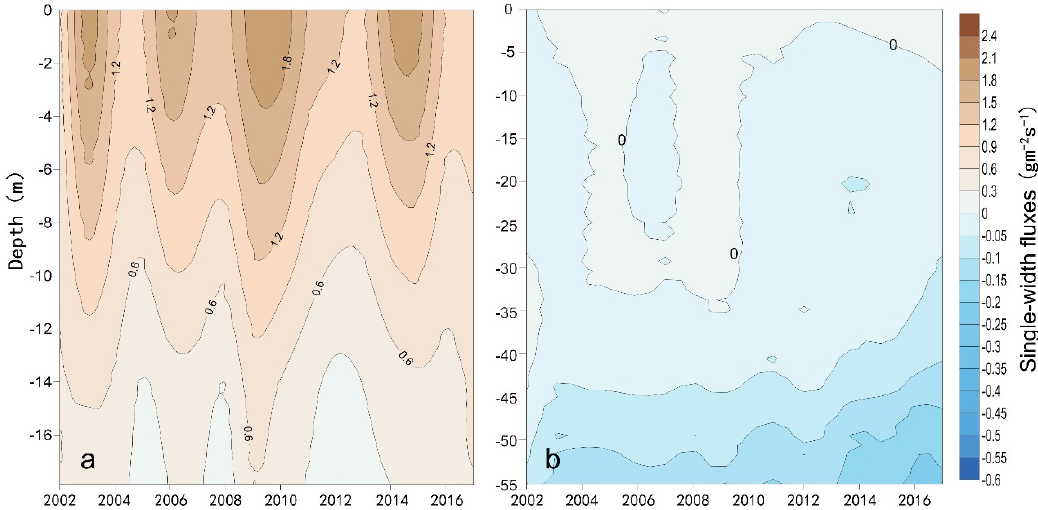
Figure 9. The multi-year variations in single-width sediment fluxes at different locations in the Bohai Strait. Location details are provided in Figure 1a. The flux at the station in the southern Bohai Strait ( a ) and in the northern Strait ( b ). Positive values indicate output flux from the Bohai Sea to the Yellow Sea, and negative values indicate input flux from the Yellow Sea to the Bohai Sea.